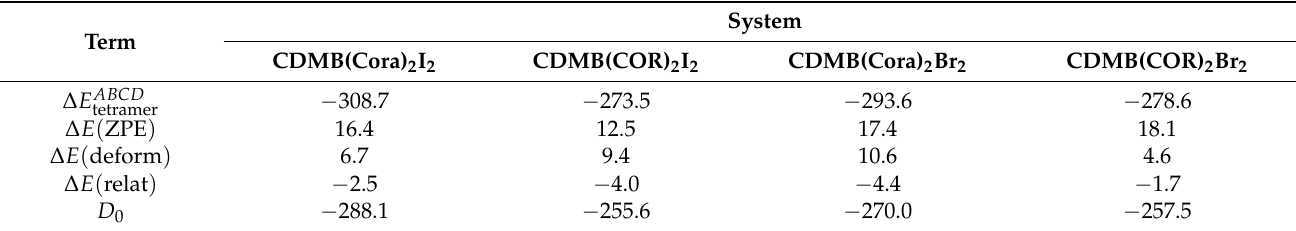
Table 3. The interaction energy contributions and the total binding energy of the investigated tetramers. All values are in kJ/mol.